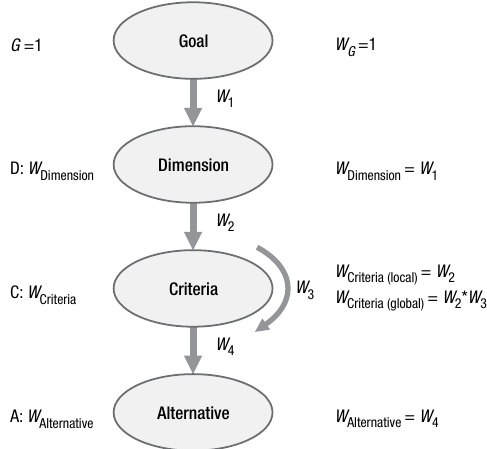
Fig. 5. The network with